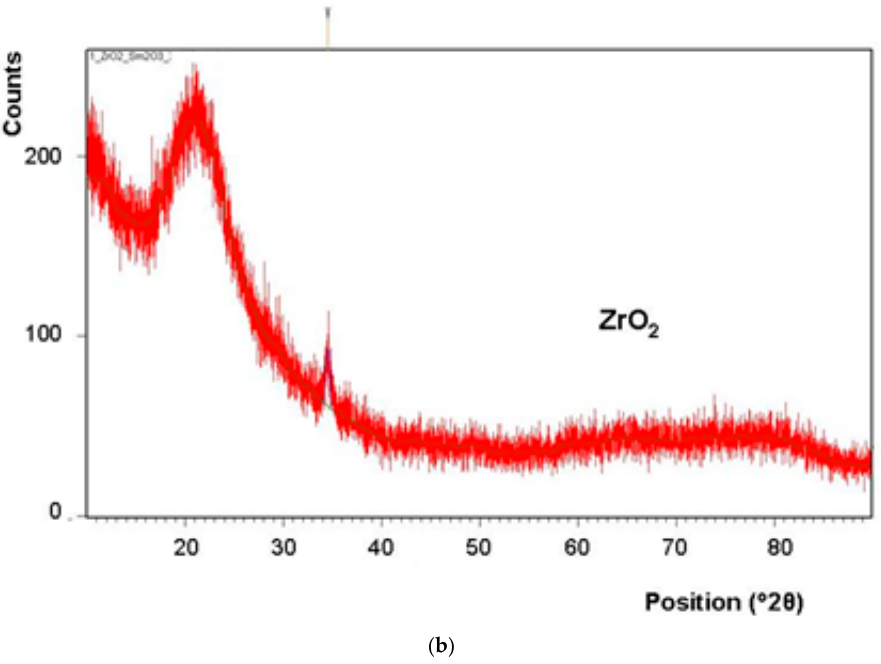
Figure 5. ( a ) X-ray diffraction pattern of the layer synthesized at 550 °C and presented in Figure 1; ( b ) deposited at 500 °C and shown in Figure 6.